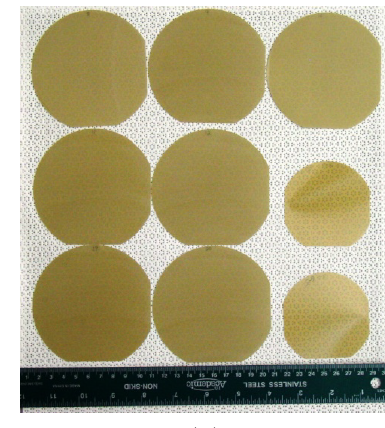
Nb )O -PbTiO (PMN-PT) crystal grown 1/3 2/3 3 3